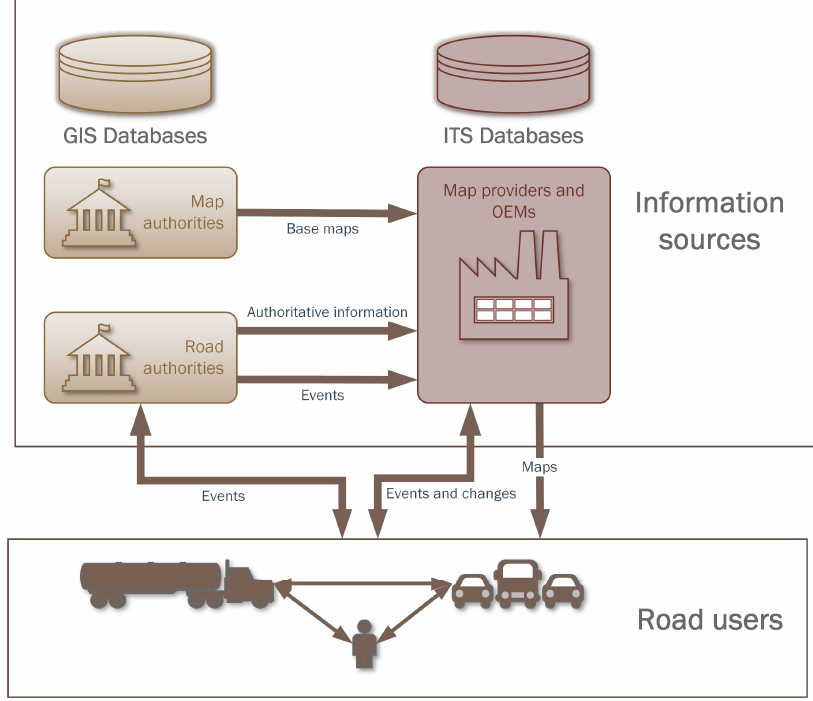
Figure 1. Parts of the flow of geospatial information in Intelligent Transport Systems (ITS).